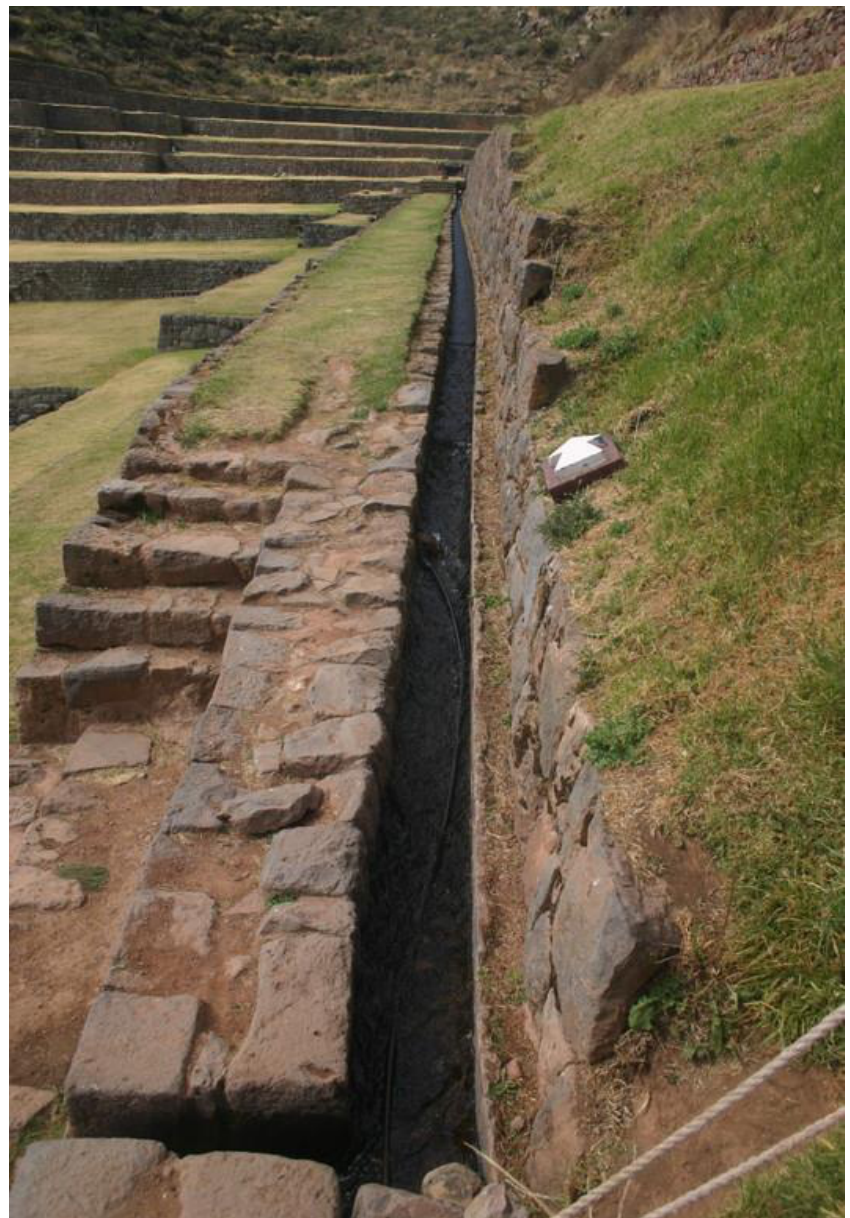
Figure 14. View of a portion of the easternmost drainage channel directing terrace seepage and rainfall runoff to lower occupation and ceremonial areas as well as for excessive water site drainage. The easternmost channel is located to the right of the Plaza Ceremonial terraces shown in Figures 1 and 2. (Photo by C. Ortloff)